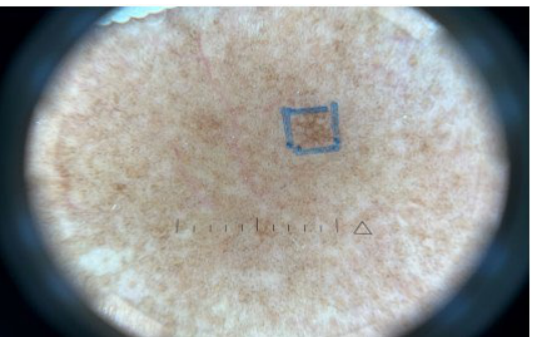
Figure 2. Pseudonetwork, gray dots/granules, telangiectatic vessels, perifollicular whitish halo, fine scales, and follicular keratotic plugs are features of Riehl’s melanosis under dermoscopy .